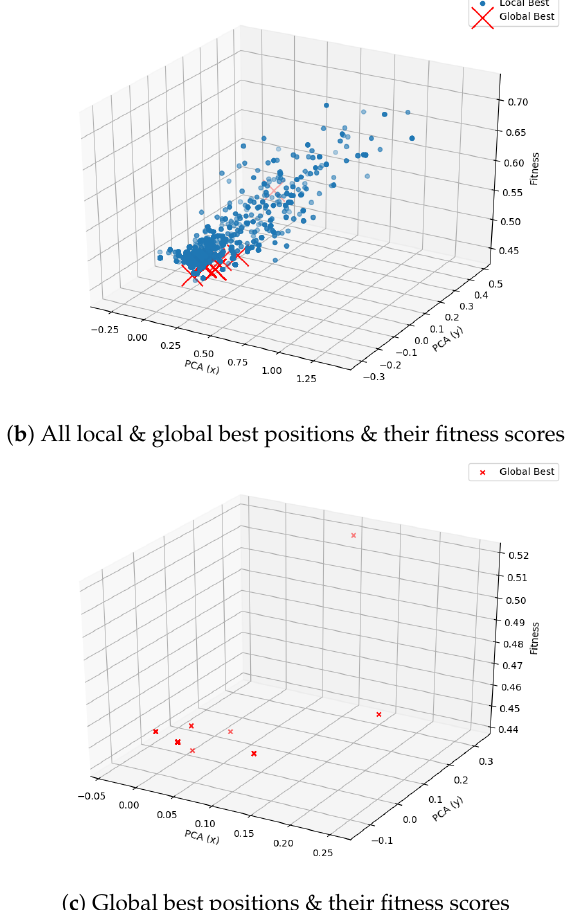
Figure 18. Example local and global best positions over time with no weight inheritance method (PCA for dimensionality reduction to display particle positions on two axes with fitness on the